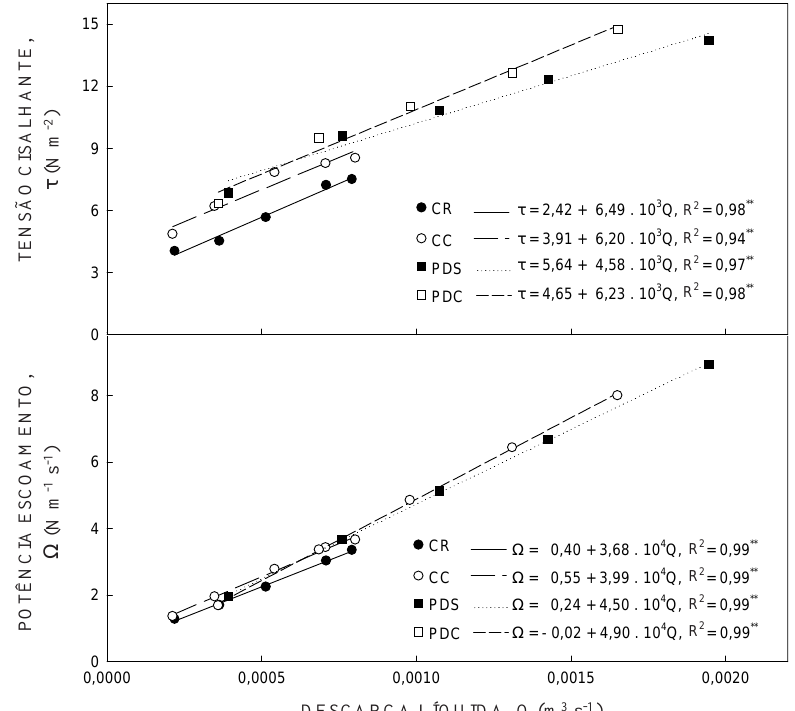
Figura 4. Tensão cisalhante ( ttttt ) e potência ( WWWWW ) do escoamento da descarga líquida (Q), considerando diferentes preparos e consolidação do solo (CR = convencional recente, CC = convencional consolidado, PDS = plantio direto sem palha, PDC = plantio direto com palha: ttttt e WWWWW atuantes no solo e no resíduo). ** = significativo (P <